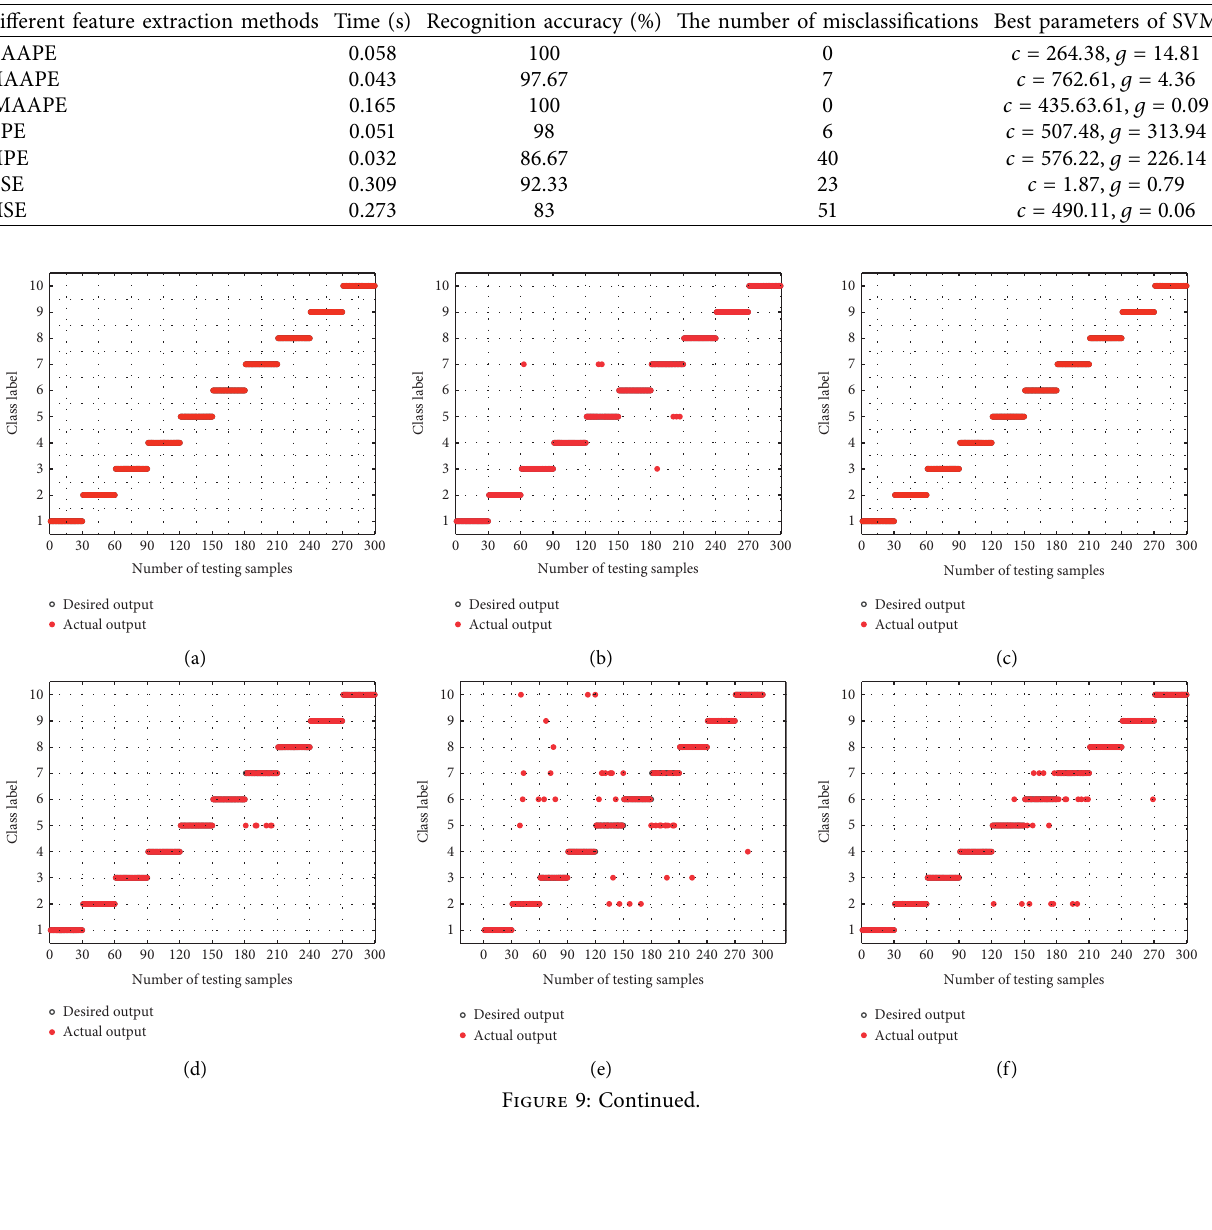
Table 4: The comparison of different feature extraction